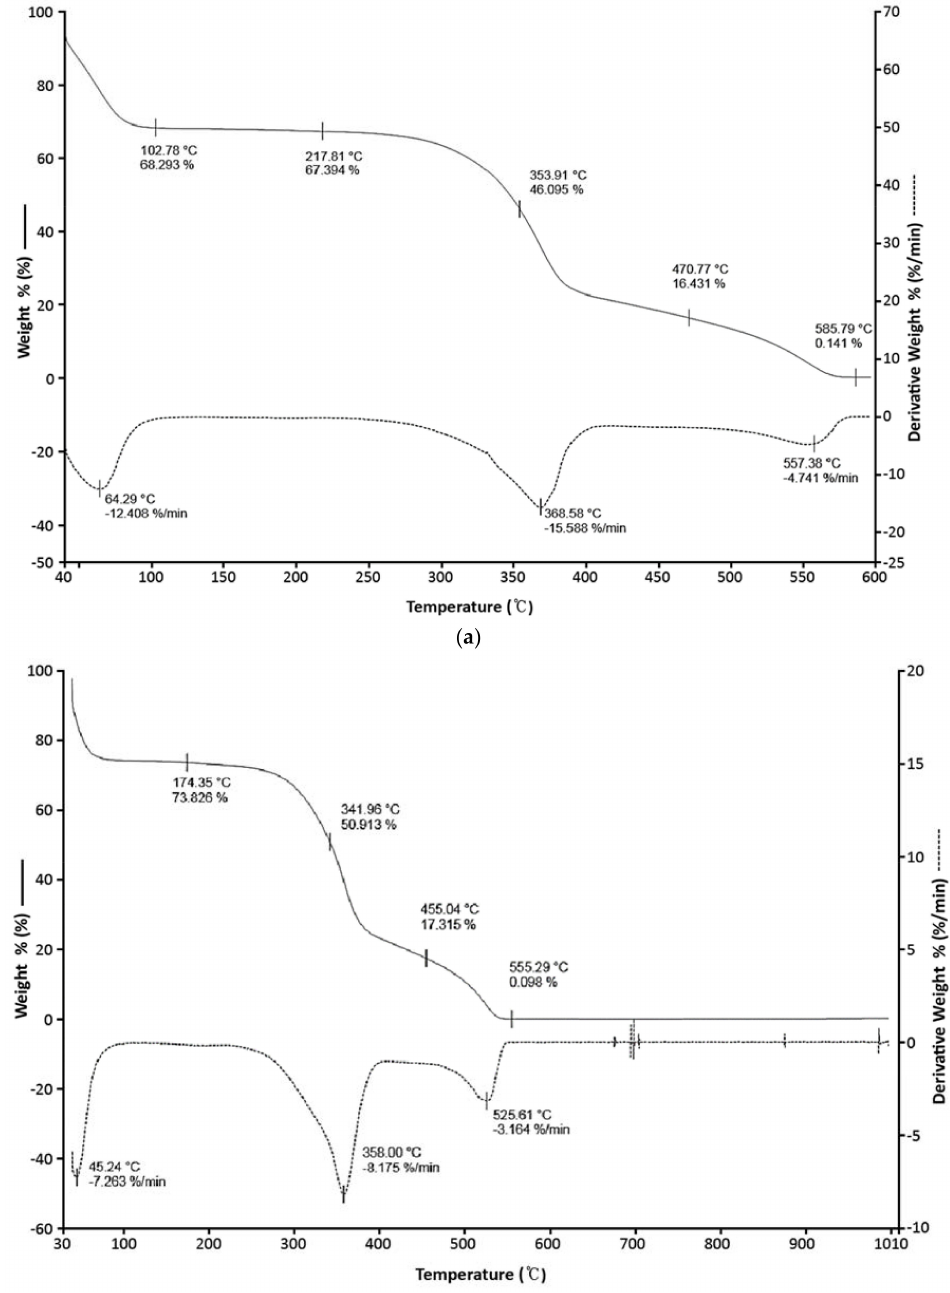
Figure 2. ( a ) Sawdust at 600 ◦ C, 20 ◦ C/min; ( b ) Sawdust 1000 ◦ C, 10 ◦